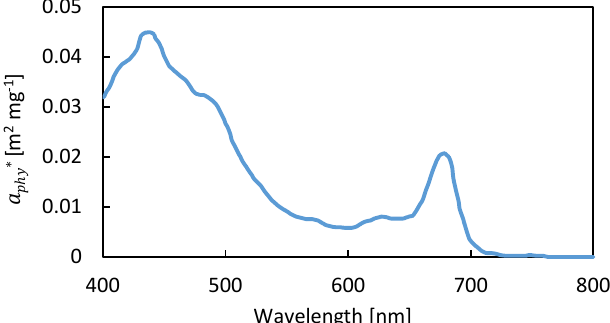
( λ ) measured in Lake Trasimeno phy